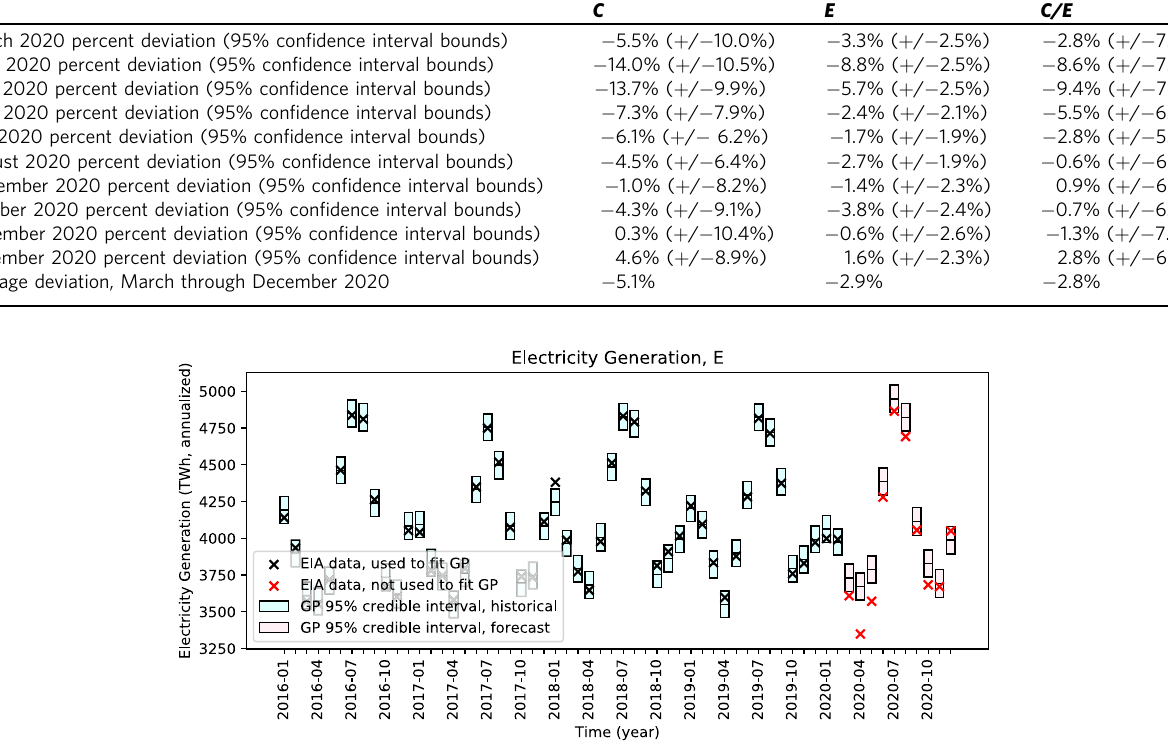
Fig. 2 Expected and observed electricity generation ( E ). Observed electricity generation is outside of (lower than) the 95% con fi dence intervals in six forecasted months: March, April, May, June, August, and October 2020.